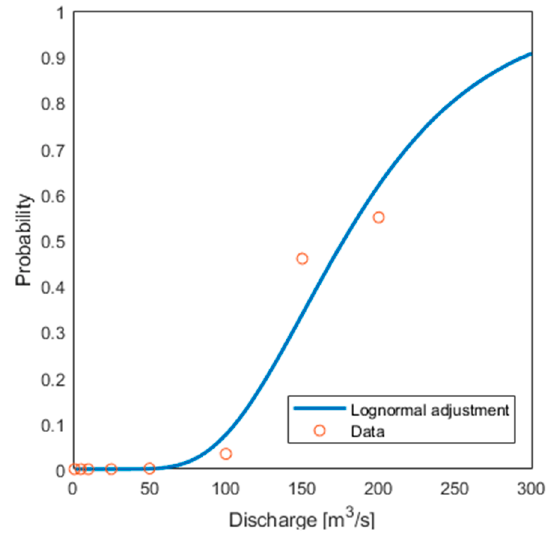
Figure 9. Fragility curve for the case study for a flow angle of attack of 0°.